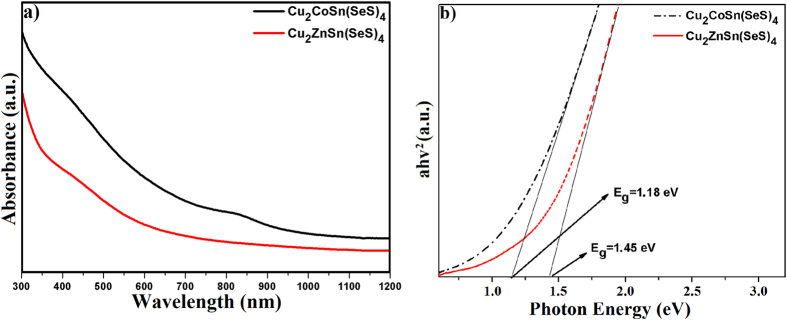
(a) UV-Vis absorption spectrums and (b) eV Diagrams of Cu2CoSn(SeS)4 and Cu2ZnSn(SeS)4 nanocrystals.